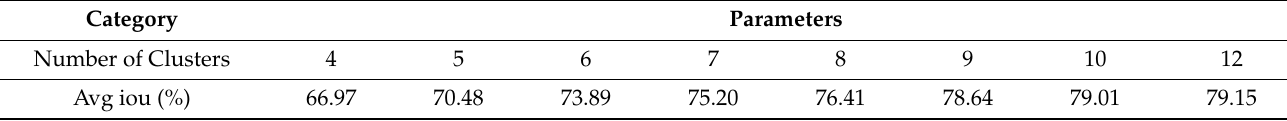
Table 3. Electric vehicle flame dataset information.